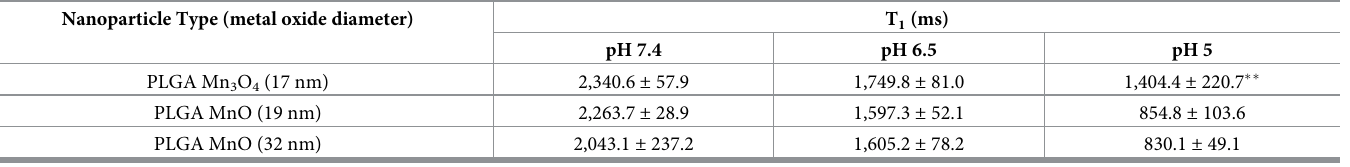
Table 3. MRI T 1 values of supernatants collected 24 hours after PLGA NP incubation at pH 7.4, 6.5 and 5. Nanoparticle Type (metal oxide